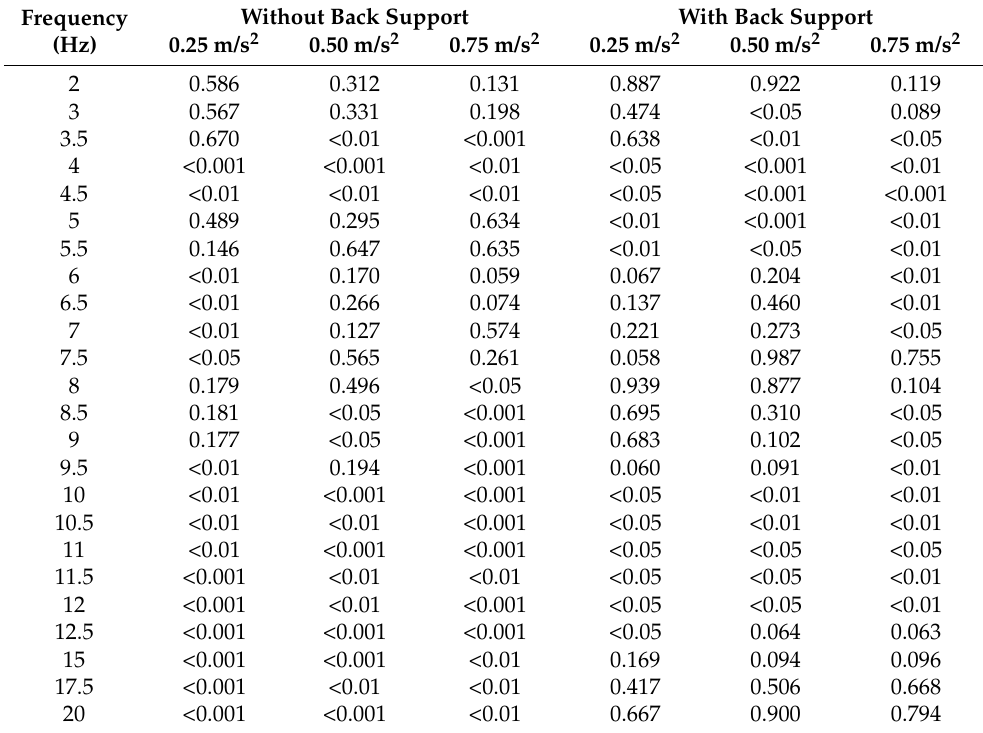
Table 6. p -values obtained from one-way r ANOVA of fore-aft STHT magnitudes among elastic seats for two sitting conditions and three levels of